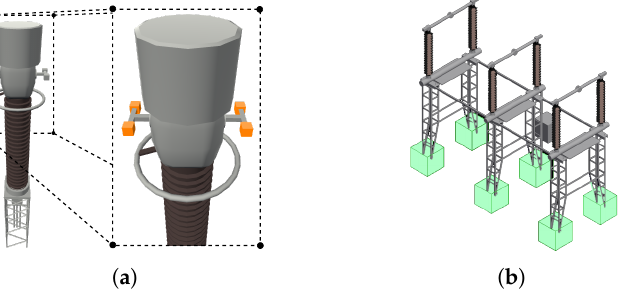
Figure 11. Convention example of reference points: ( a ) reference of connectors for electric conductors; ( b ) references for support bases to the